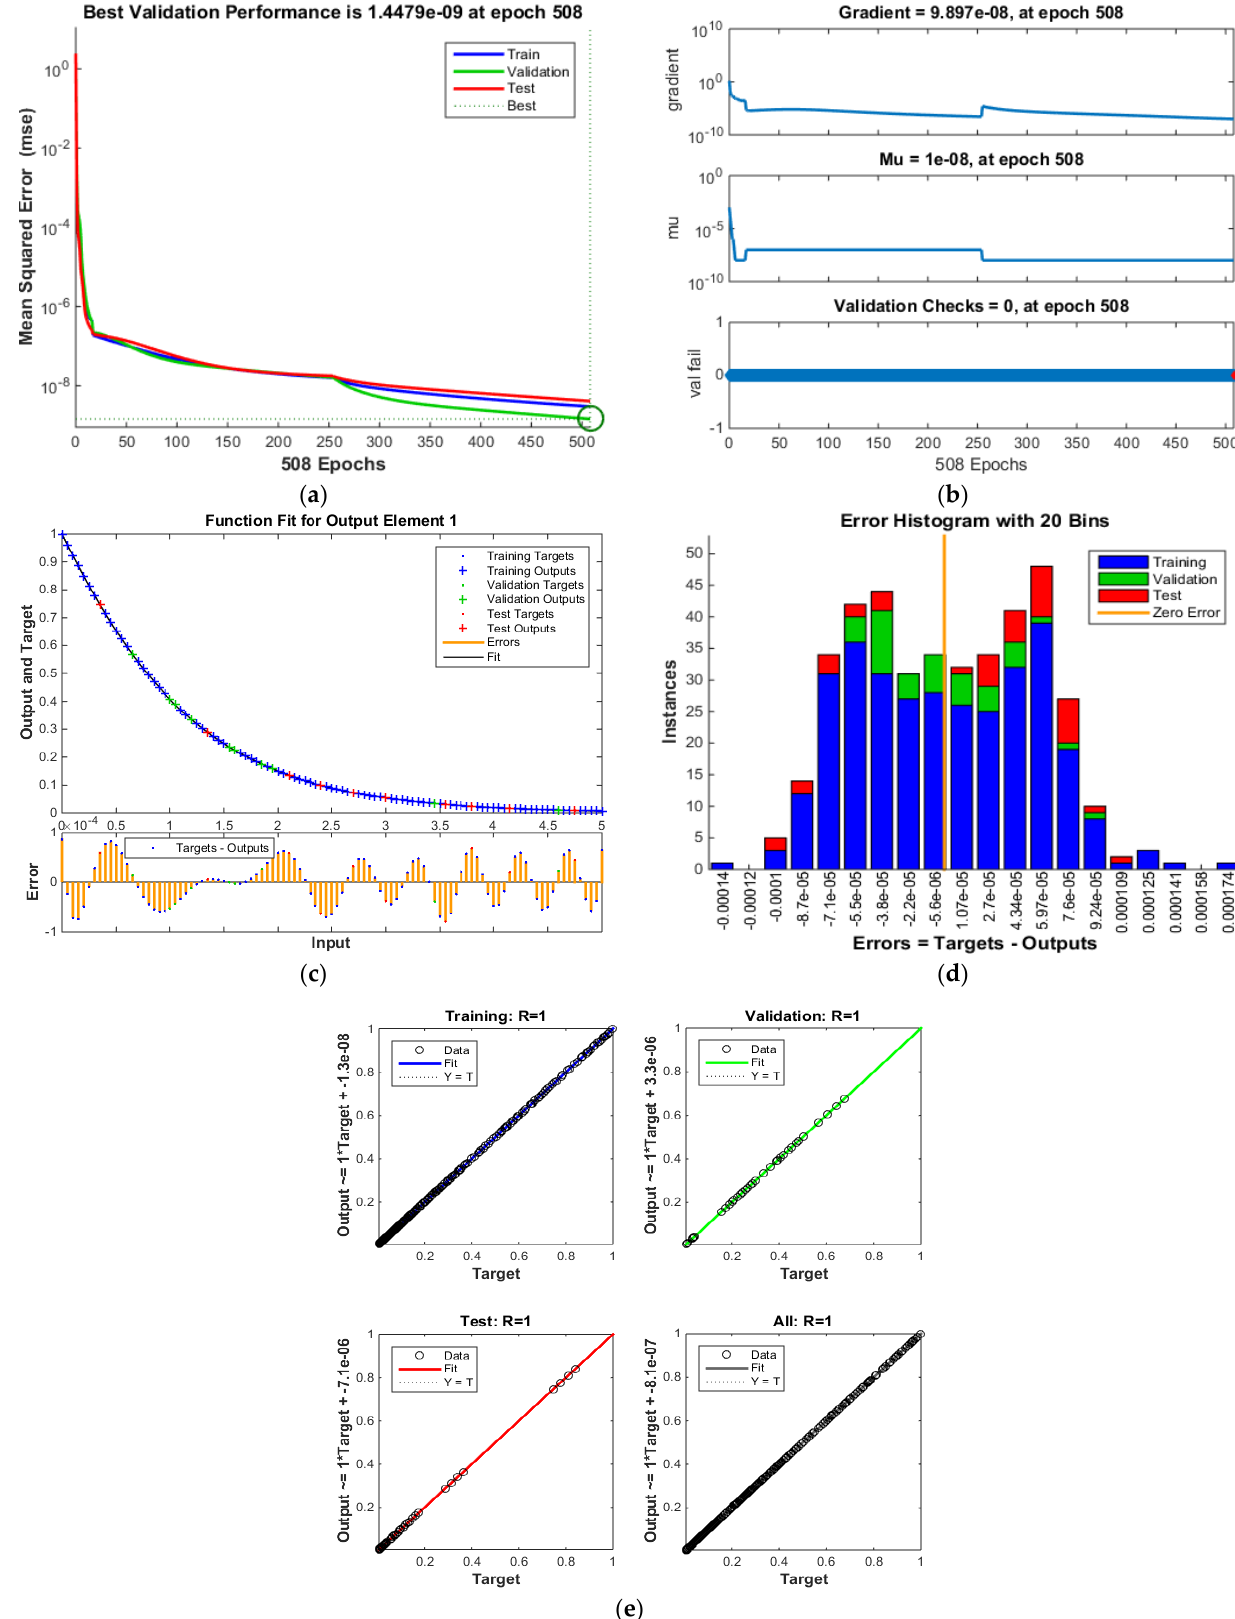
Figure 8. Graphic representation for designed LMT-ABPNN for solving cases of M for θ ( η ) of MHD-SGFM. ( a ) MSE Result, ( b ) Results of the transition state, ( c ) Fitness of the curve, ( d ) Histogram for error analysis, ( e ) Regression.